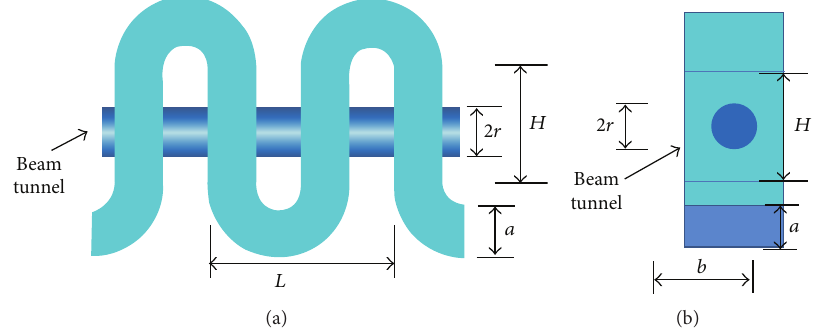
Figure 7: Illustration of (a) side view and (b) front view of the FWG